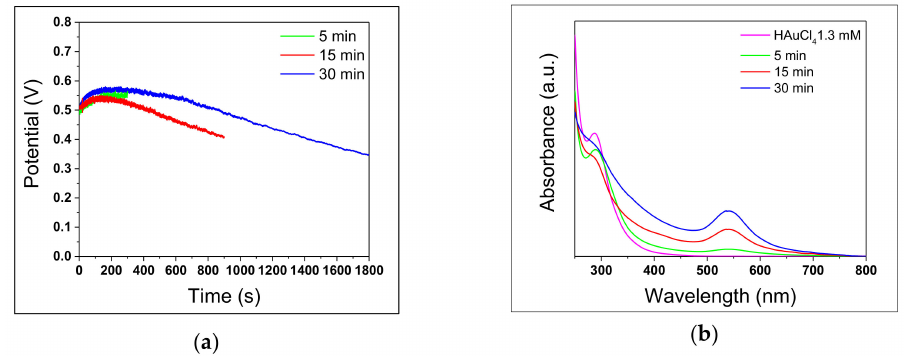
Figure 6. AuNPs synthesis performed with AISI 430 at di ff erent reaction times. ( a ) Open Circuit Potential (OCP) values, measured vs Ag / AgCl, KCl sat reference electrode; ( b ) UV-Vis absorption spectra of the as-prepared